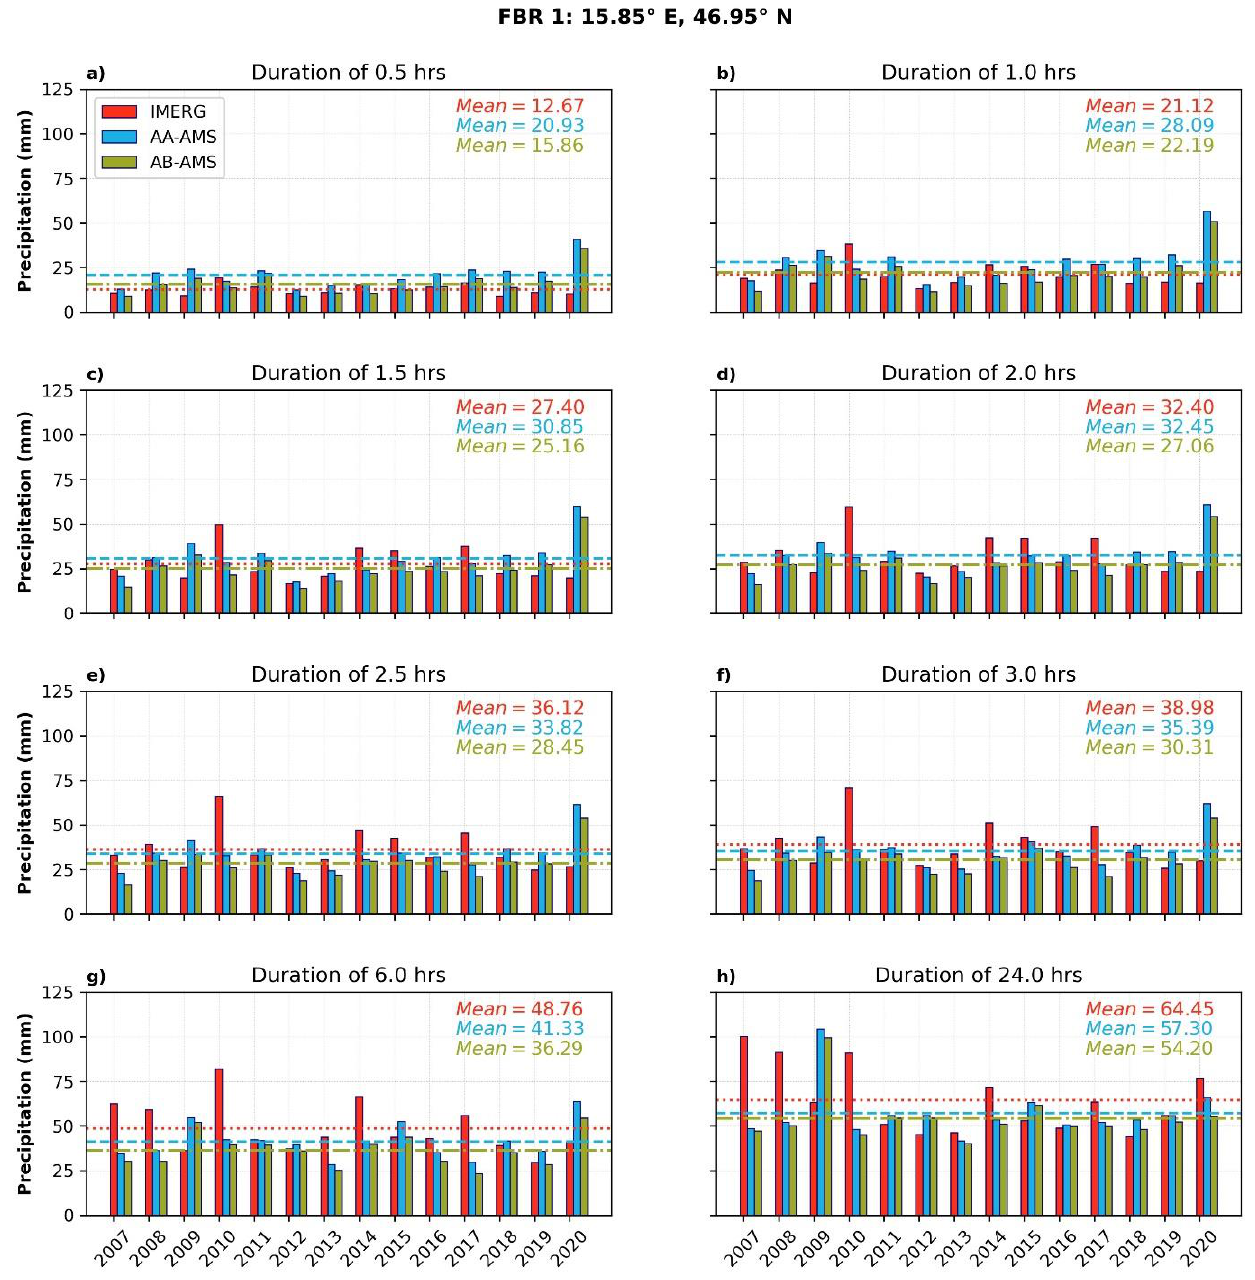
Figure A1. Annual maximum time series for FBR 1 by durations. The subfigures illustrate event durations of 0.5-h ( a ), 1-h ( b ), 1.5-h ( c ), 2-h ( d ), 2.5-h ( e ), 3-h ( f ), 6-h ( g ), 24-h ( h ). In all the subfigures, thered bars are the IMERG AMS, the light blue bars are the AA-AMS, and the green bars are the AB-AMS. The dashed lines are the mean AMS for each case.